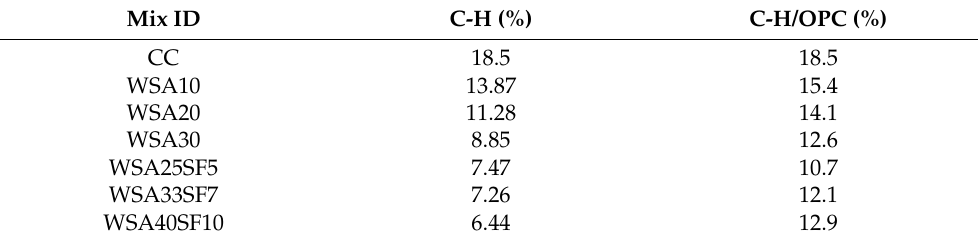
Table 7. Actual amount of calcium hydroxide (C-H) and normalized with respect to the percent content of cement in each mix (C-H/OPC) after 91 days of cement hydration.